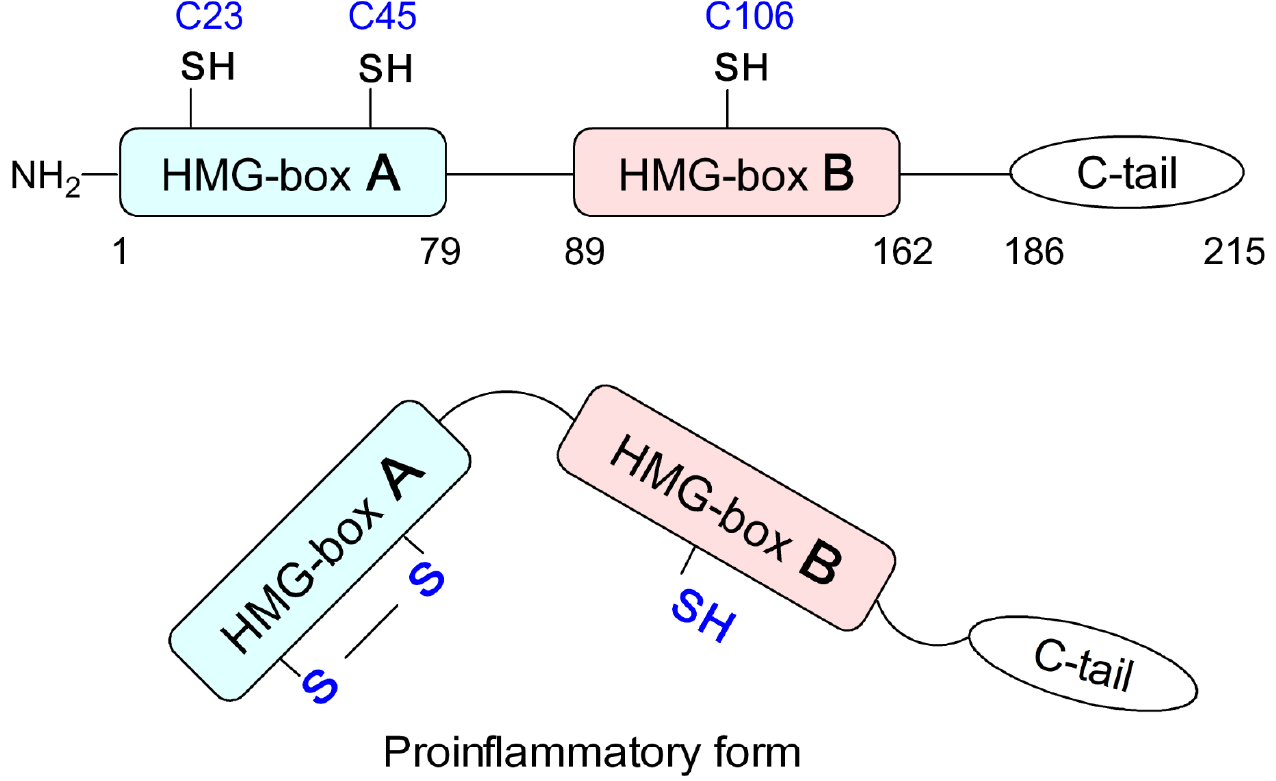
Figure 1. The structure and pro-inflammatory modification of HMGB1 protein. Mild oxidation of sulfhydryl groups of C23 and C45 within the HMG-box A results in a disulfide bond, converting the protein to a pro-inflammatory molecule. C, cysteine; C-tail, acidic C-terminus of HMGB1; SH, sulfhydryl group of cysteine.